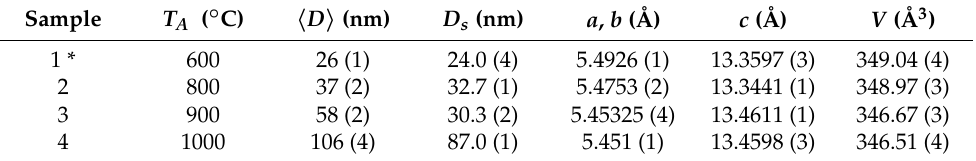
Table 1. Crystallographic and morphological parameters for produced NPs, obtained from Rietveld refinement and TEM images. T A represents the annealing temperature; (cid:104) D (cid:105) and D s are, respectively, the mean NP diameter obtained from NP size distribution and Scherrer equation; a , b and c represent the lattice parameters, obtained from Rietveld refinements, while V is the unit cell volume.